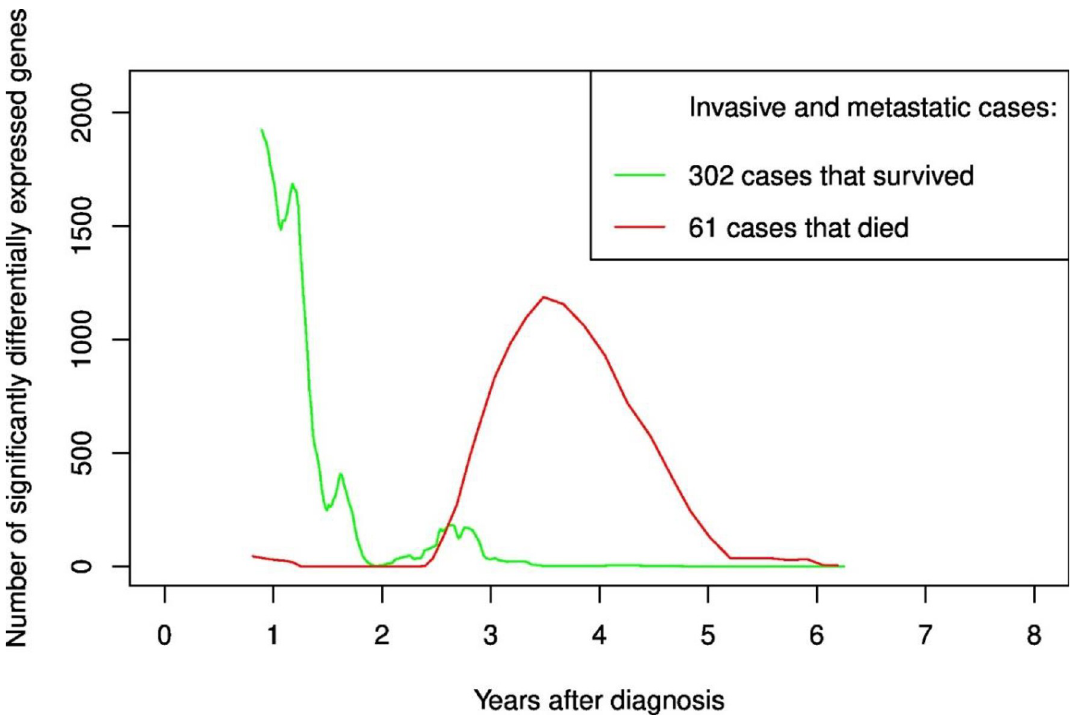
Fig 4. Number of significantly differentially expressed genes for each follow-up time period stratified on vital status at the end of follow-up; death or survival.